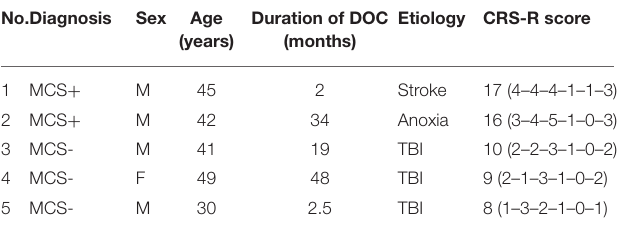
TABLE 1 | Clinical characteristics of patients with disorders of consciousness. No.Diagnosis Sex Age Duration of DOC (years) (months)